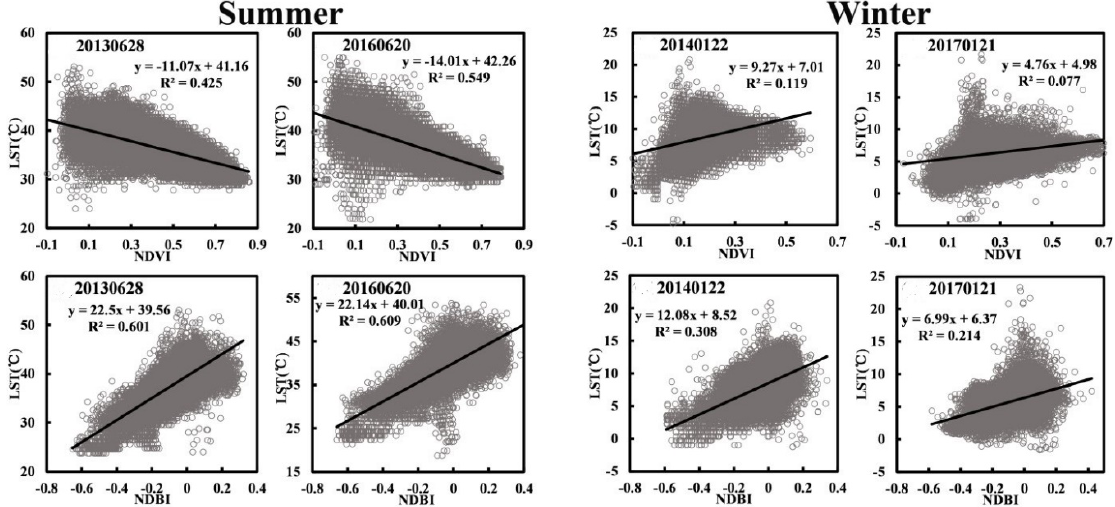
Figure 12. The correlation of LST with NDVI and NDBI in summer and winter.